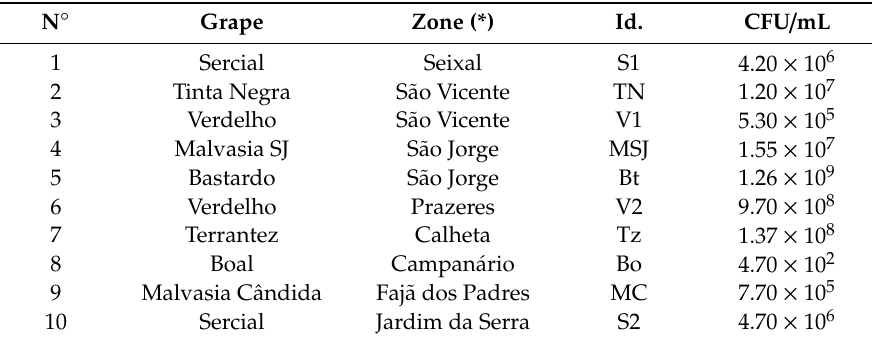
Table 1. Number of colonies obtained for each microfermented wine.